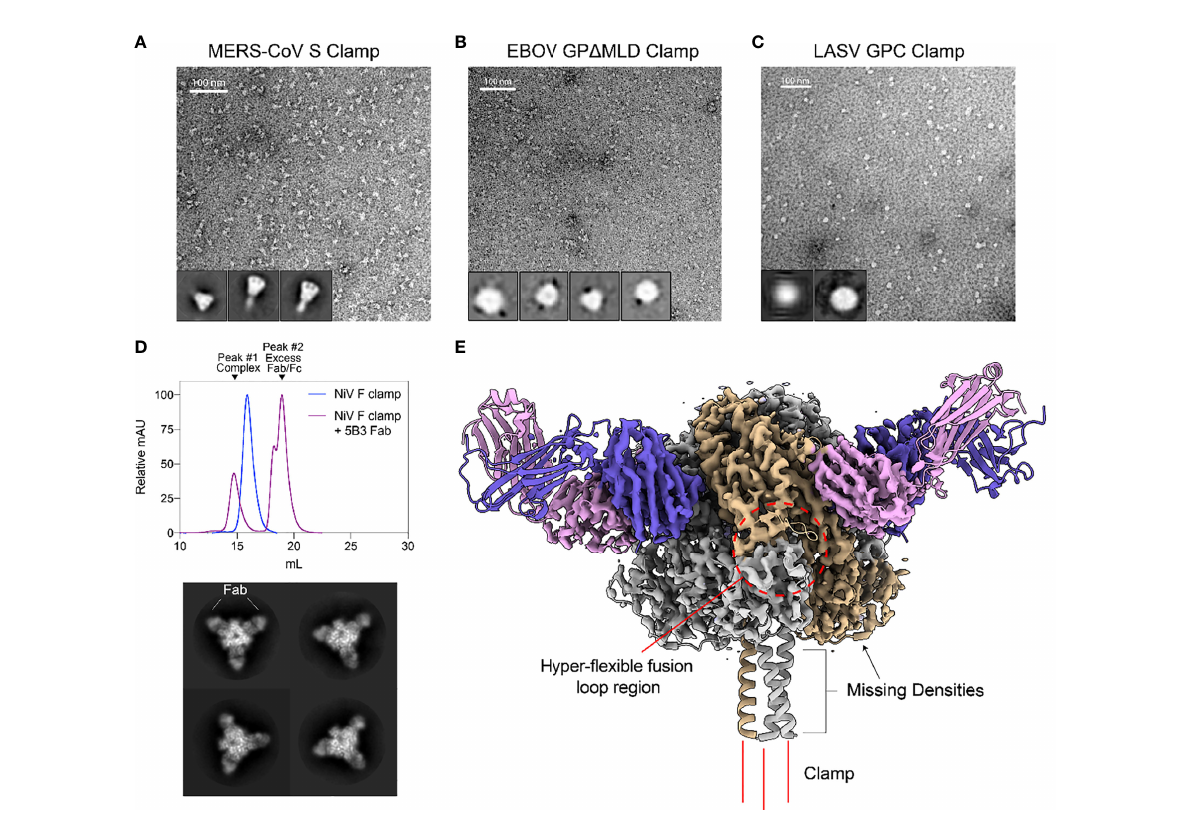
FIGURE 2 Structural validation and characterization of molecular clamped-stabilized antigens. (A) Representative negative stain TEM micrographs and 2D classes of MERS S Clamp, (B) EBOV GP D MLD Clamp, and (C) LASV GPC Clamp. Clamp antigens were stained with 1% (w/v) uranyl acetate and imaged on a Hitachi HT7700 Transmission Electron Microscope at 120 kV. 2D classes were generated using Relion 3.1 software. (D) SEC of 5B3 Fab complexed or uncomplexed NiV F Clamp antigen separated on Superose 6 Increase 10/300GL column. Each data set is normalized to its maximal value. Below, representative 2D class averages of 5B3 complexed NiV F clamp. (E) 3.3 Å resolution cryo-EM structure of 5B3 complexed NiV F Clamp with the previously solved atomic structure (PDB 5EVM, PDB 6U1T) fi tted in ribbon form. NiV F clamp is coloured in grey with a single monomer in gold. 5B3 heavy chains are coloured purple and light chains in pink. Unsolved clamp domain shown as three red lines at the